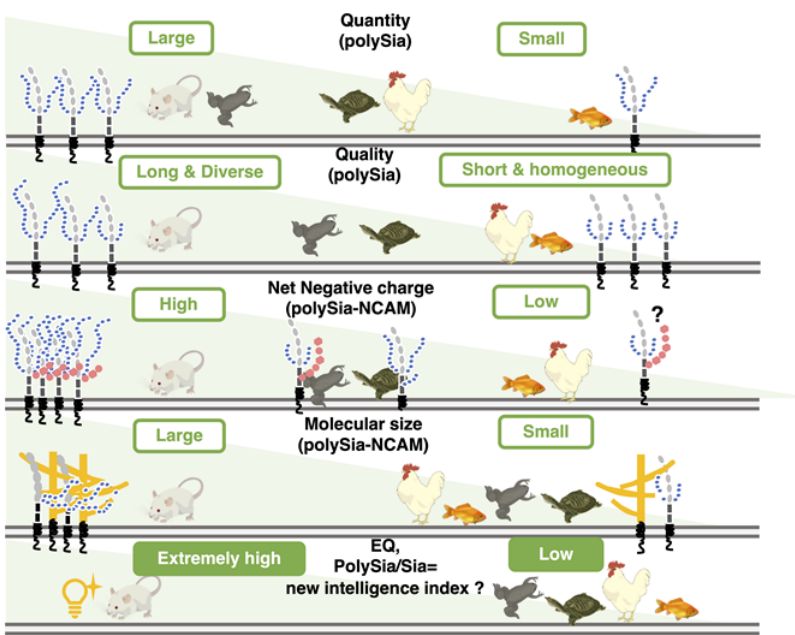
Figure 11. The quantity and quality of polySia and the features of polySia-NCAM in five different vertebrate brains. PolySia-NCAM is highly regulated in both quantity and quality (DP, net negative charge, and size) among the five different vertebrate brains.